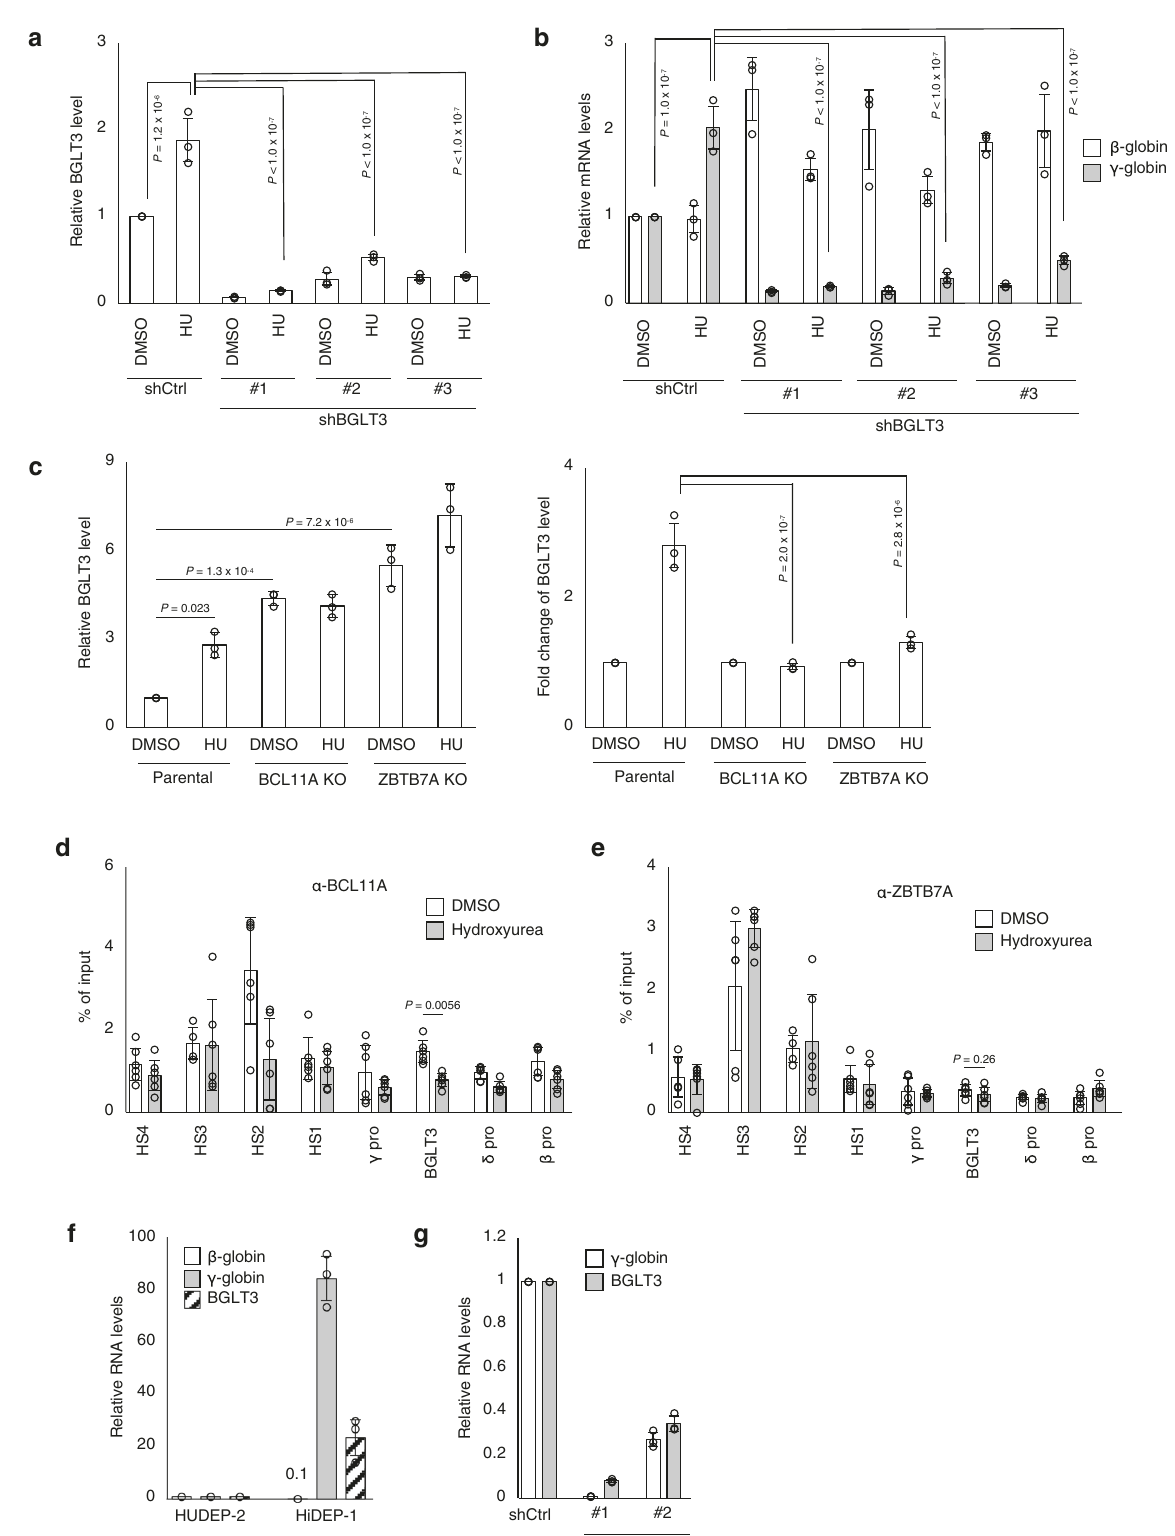
BGLT3 lncRNA appears to play a key role in HbF induction by various small molecules. Even in HiDEP-1 cells, which maintained high γ -globin expression (Fig.7f),thisexpressionwascompletelydependent onBGLT3(Fig.7g), suggesting that the importance of BGLT3 is not limited to pharmaco- logical γ -globin induction. Gene expression pro fi ling during